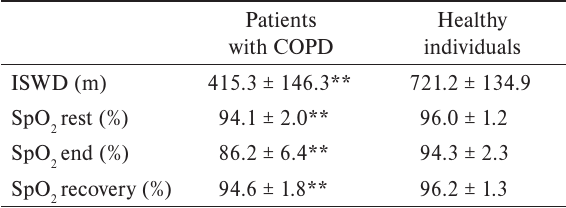
Results of ISWT test (mean ± SD)